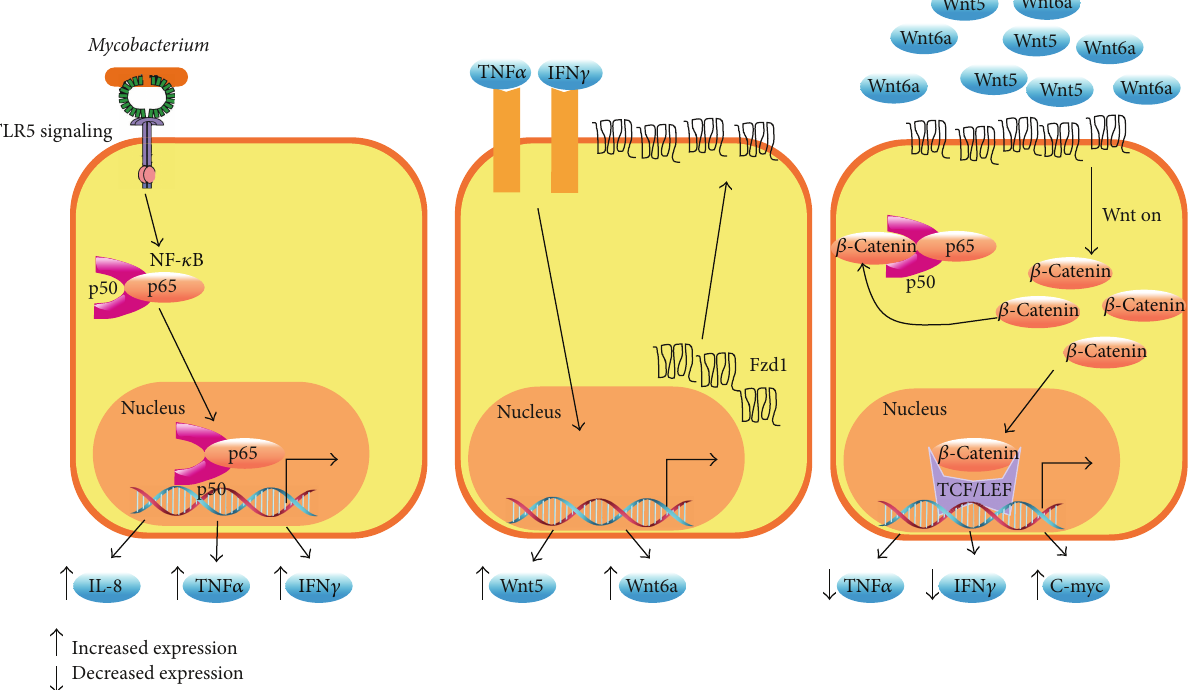
Figure4:Frizzledreceptorsreduceinflammation.Inepithelialcellsandmacrophages, Mycobacteriumtuberculosis inducesNF- 𝜅 B-dependent expression of IL-8, TNF 𝛼 , and IFN 𝛾 (left panel) through TLR signaling. In turn, TNF 𝛼 and IFN 𝛾 stimulation increases Fzd1, Wnt6, and Wnt5a expression at the membrane cell surface (middle panel). Finally, the binding of Wnt3a, Wnt5a, or Wnt6 to Fzd1 (right panel) induces stabilization of 𝛽 -catenin, inhibiting the NF- 𝜅 B pathway. This interaction of 𝛽 -catenin with NF- 𝜅 B decreases the expression of proinflammatory molecules such as TNF 𝛼